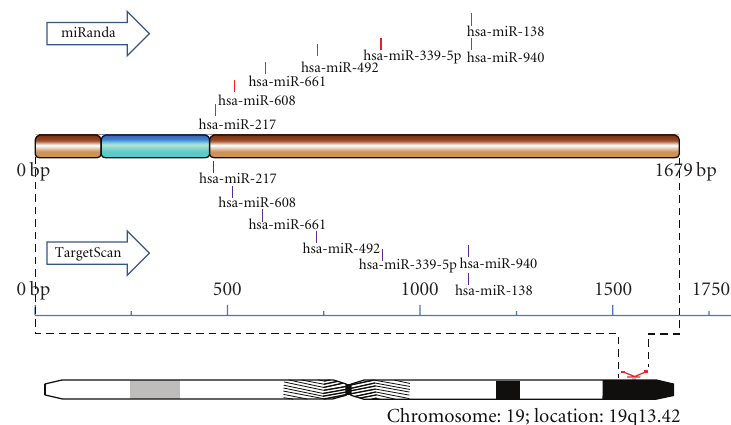
Figure 8: Schematic representation of miRNA targets on COX6B2.